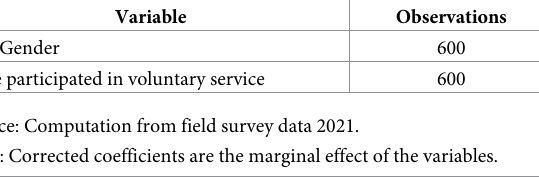
Table 5. Mean and standard deviation of corrected coefficients for significant variables in outcome equation that also appeared in the selection equation.